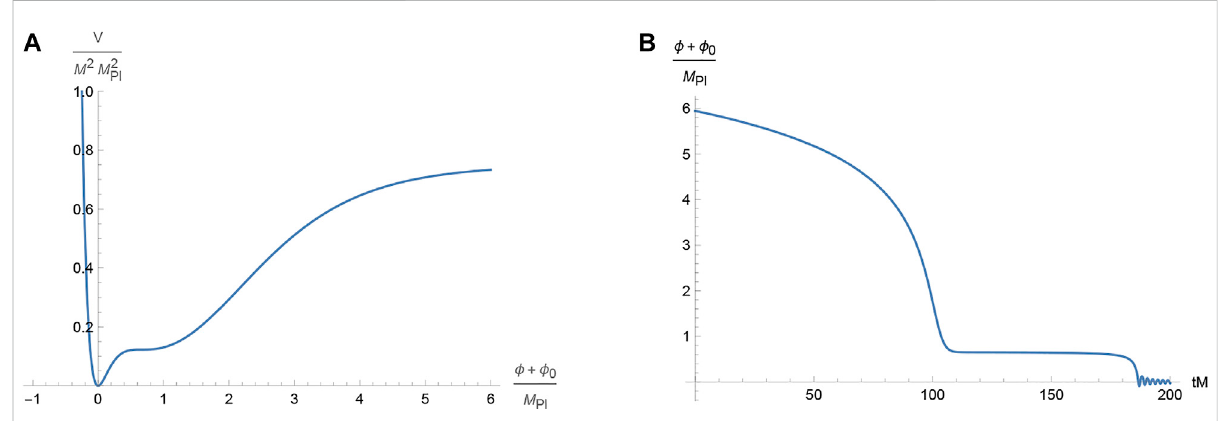
FIGURE 1 Apro fi leofthescalarpotential (A) andthein fl atondynamics (B) fortheparameters α =0.739, ϕ i + ϕ 0 =0.664 M Pl and ξ =0.012withthevanishing initial velocity. The location of the in fl ection point is speci fi ed by the value of ( ϕ i + ϕ 0 )/ M Pl